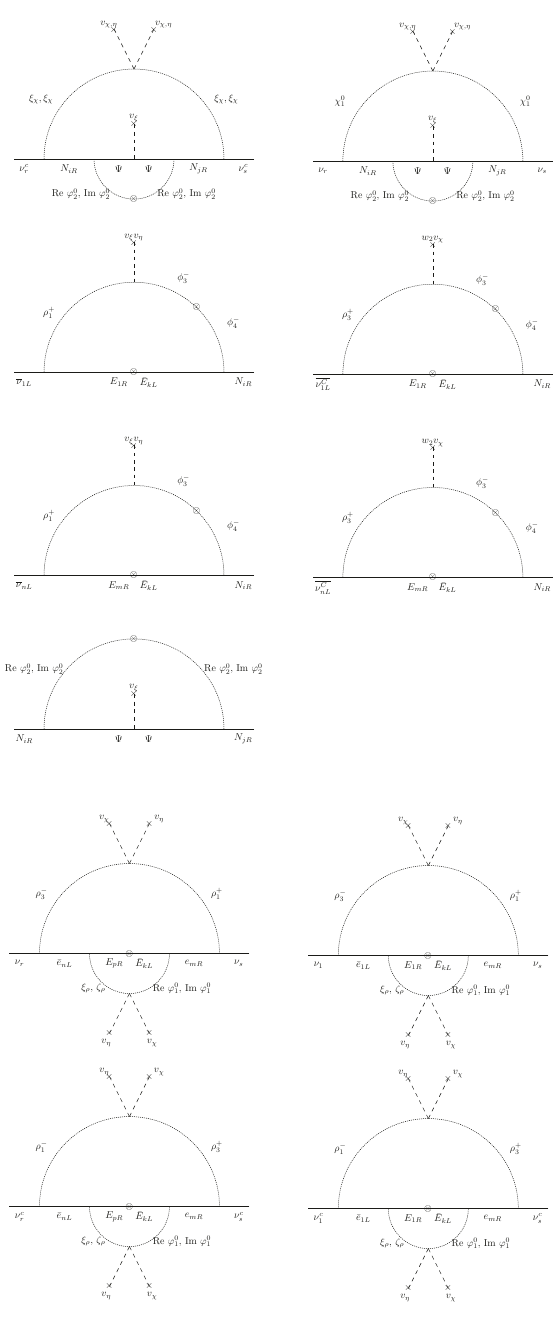
Figure 3 . Loop Feynman diagrams contributing to the entries of the neutrino mass matrix. Here n; m; k; p; r; s = 2 ; 3 and i; j = 1 ; 2 ; 3, whereas w 2 corresponds to the mass dimension coe(cid:14)cient of the trilinear scalar coupling (cid:30) + (cid:26) y (cid:31) . The cross mark in the internal lines correspond to the softly 3 (cid:10) breaking mass insertions.